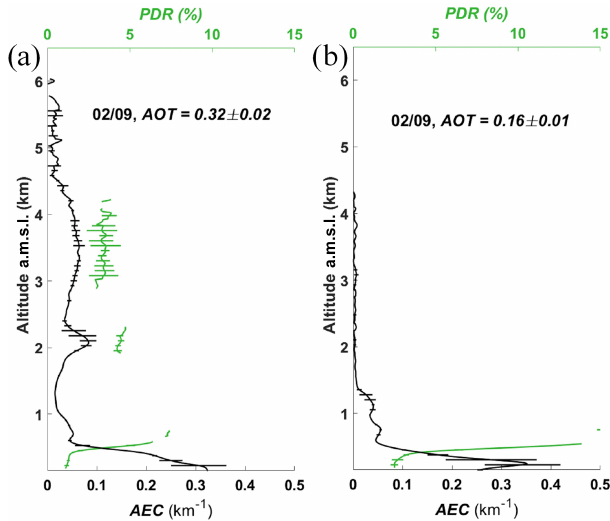
Figure 5. Vertical profiles of the AEC and PDR at 355nm with their uncertainties (horizontal bars) for the transition period on 2 Septem- ber 2017 at (a) 09:30–11:30UTC and (b) 17:15–19:00UTC. The total AOT at 355nm is also given for each profile with its uncer-